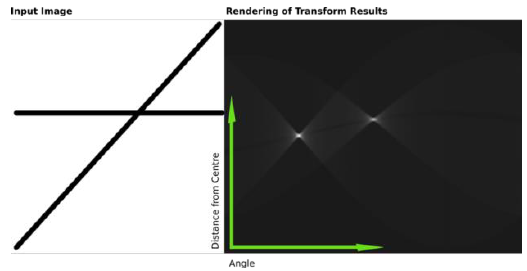
Figure 1. An example of Hough transform for lines identification. Initial image (on the left) and accumulator (or the right).